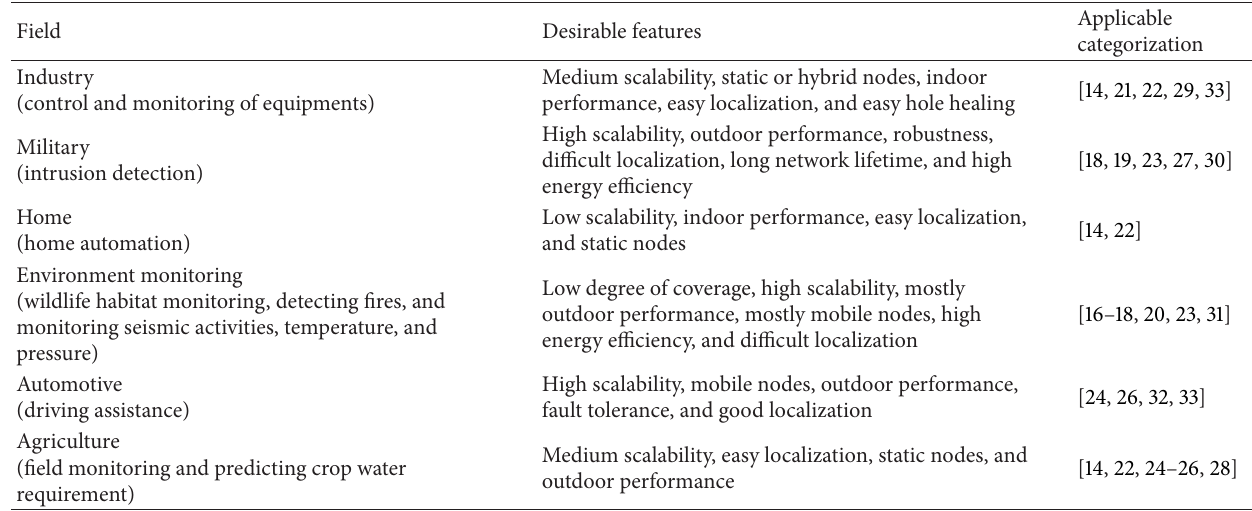
Table 4: Application suggestions for coverage hole detection